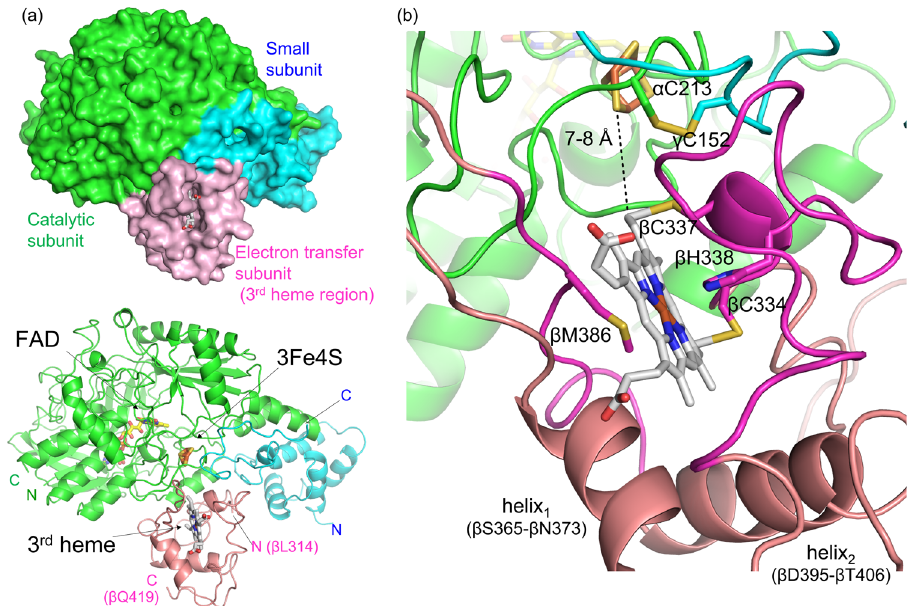
Fig. 1 Structure model of BcGDH heterotrimer complex. a Overall structure of the constructed model based on crystal structure analysis. Surface model (up) and cartoon model (down) are shown. b Modeled structure around partial electron transfer subunit. α Cys213 and γ Cys152 form an intrinsic disul fi de bond between catalytic and small subunits as previously reported. β Cys334 and β Cys337 likely interact with the thioether of the third heme in the catalytic subunit. β His338 and β Met386 are predicted as the two axial ligands of the third heme iron. α denotes the catalytic subunit, γ denotes the small subunit, and β denotes the electron transfer subunit; colored with green, cyan, and pink, respectively. FAD and 3Fe4S are shown in yellow stick model, third heme c is shown in white stick model. N and C indicate N-terminus and C-terminus of each subunit, respectively. In the electron transfer subunit, helix 1 ( β Ser365- β Asn373), helix β Asp395- β Thr406), and two regions colored with magenta ( β Cys334 to β Thr358 and β Ile384 to β Asn394) surround the third heme c 2 (